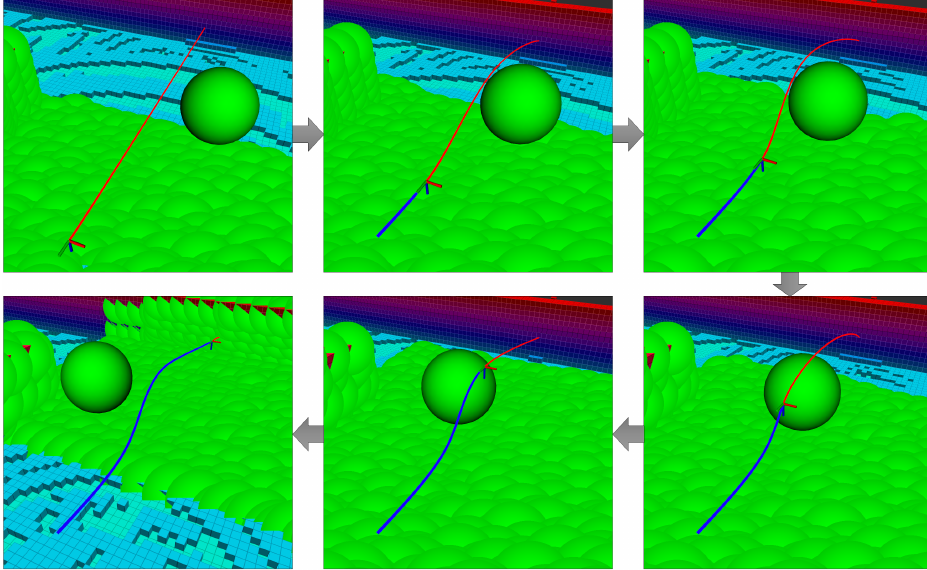
Figure 15. Obstacle avoidance for a moving object. The object (sphere) is moving to the left. The NMPH regenerates the red path continuously to avoid the object. The blue curve represents the flight trajectory of the